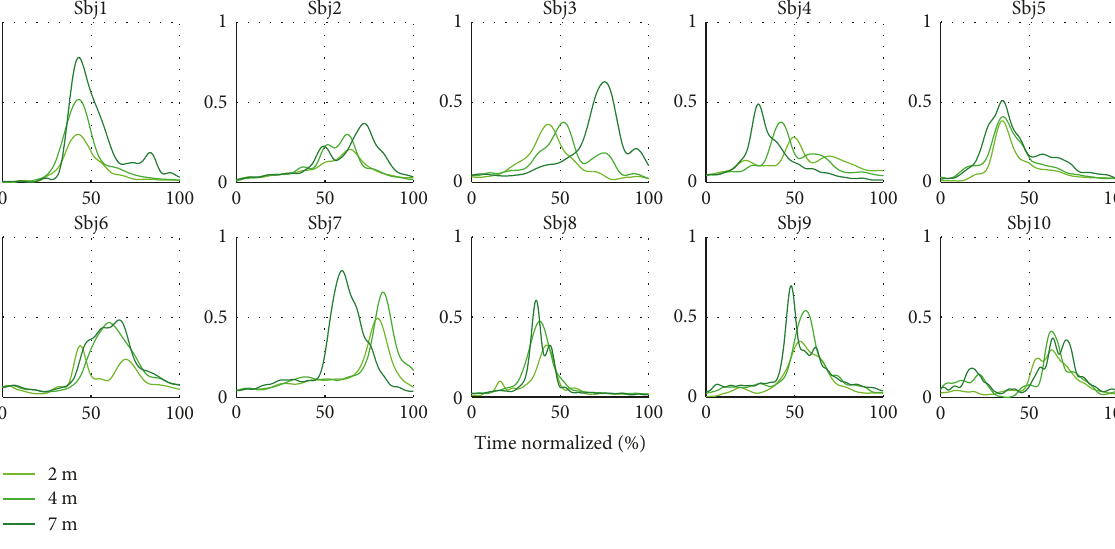
1 per subject and throwing